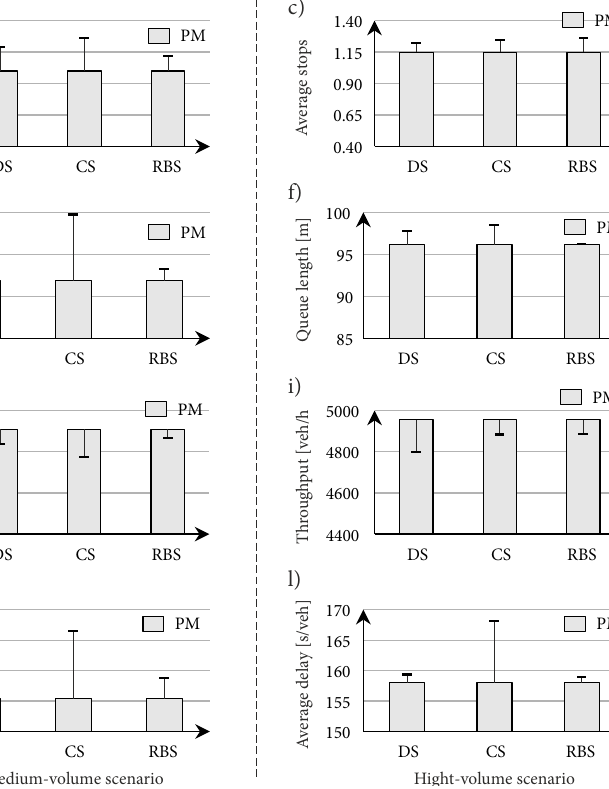
Figure 9. Simulation verification